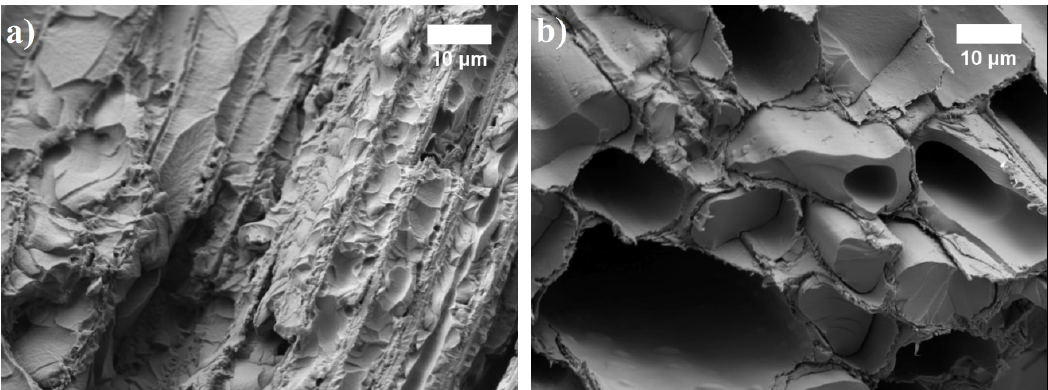
Figure 7. The density of different oil-impregnated BcBs. G, H, F—composition of the boards, impregnated at 90 °C hardening temperature. —linseed oil, —tung tree oil, —without oil treatment: solid-type bars—specimens which were dried at 70 °C to constant weight; pattern-type bars—specimens which were dried at 23 ± 2 °C and 50 ± 2% conditions to constant weight.